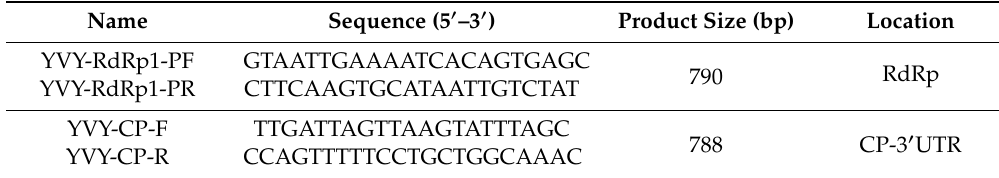
Table 3. Primers used for detection of YVY.